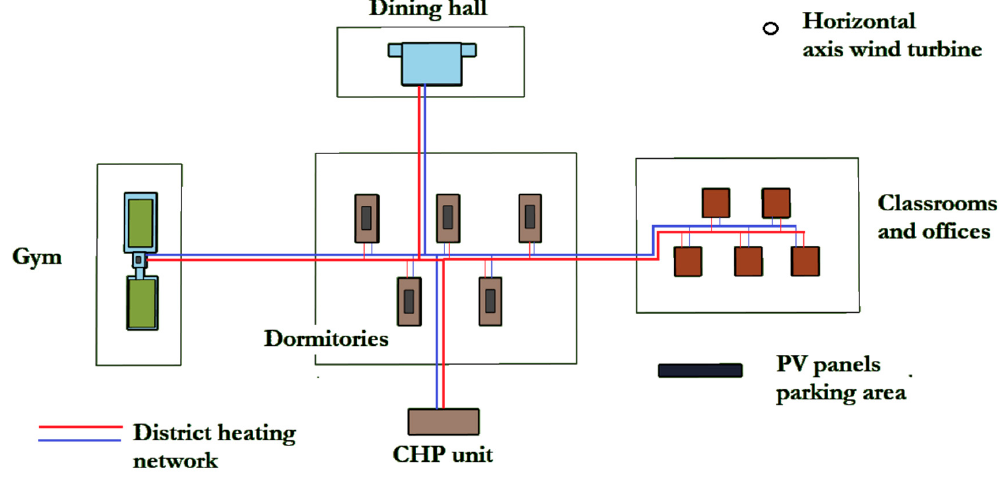
Figure 3. Scale representation of the campus: buildings, district heating, and generation